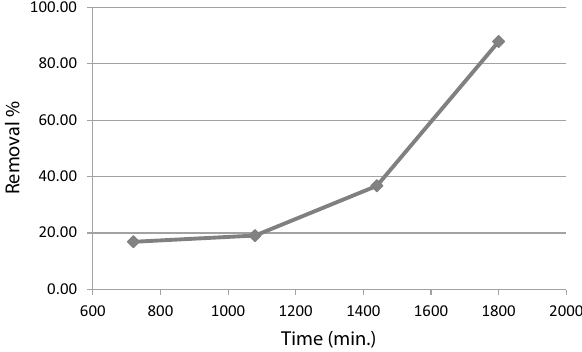
Fig. 8 Initial Congo dye concentrations versus removal (%) by Asper- gillus niger